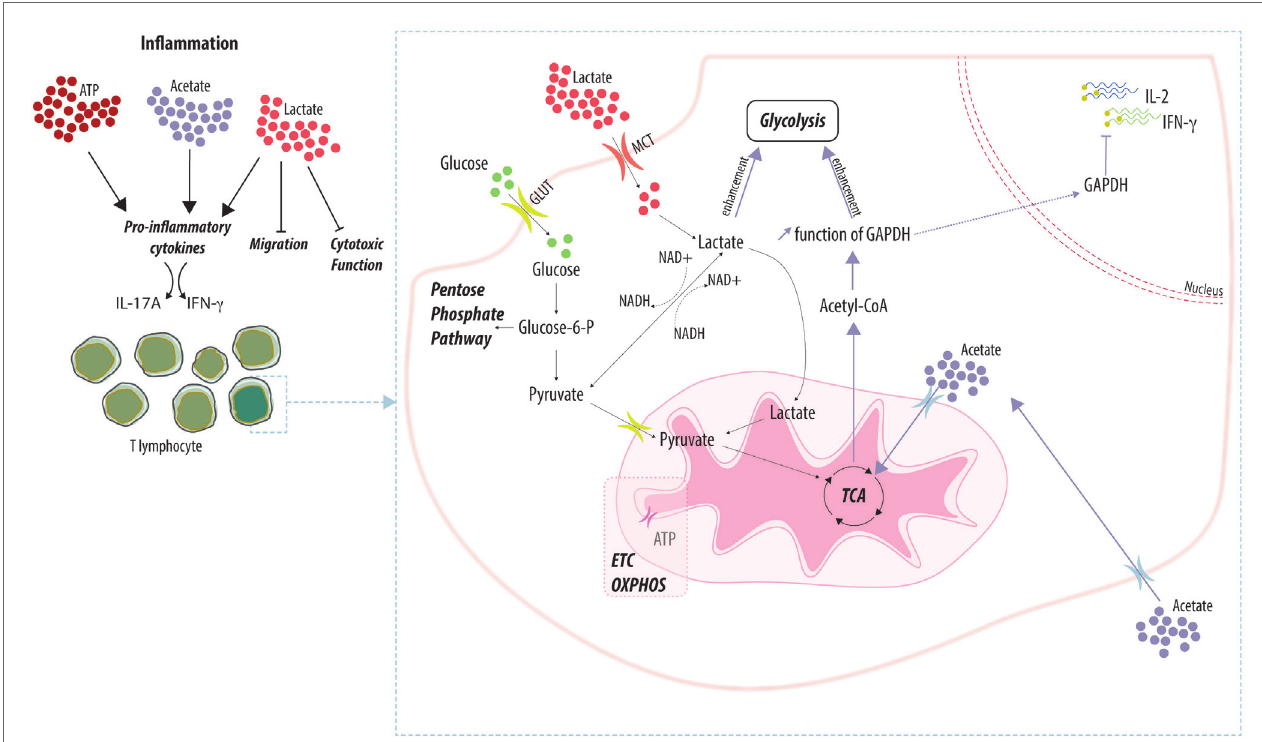
FiGURe 1 | Adaptation of T cell function to the local metabolic environment. Local concentrations of metabolic by-products (e.g., ATP, acetate, and lactate) differentially impact the function of T lymphocytes. Accumulation of metabolites favors the effector function by enhancing the secretion of pro-inflammatory cytokines while favoring the retention of T cells within the inflamed tissue. Lactate and acetate are actively imported into T cells and fuel the main metabolic pathways. Enhancement of the glycolytic rate prevents the inhibitory effect of the glycolytic enzyme GAPDH on the translation of pro-inflammatory